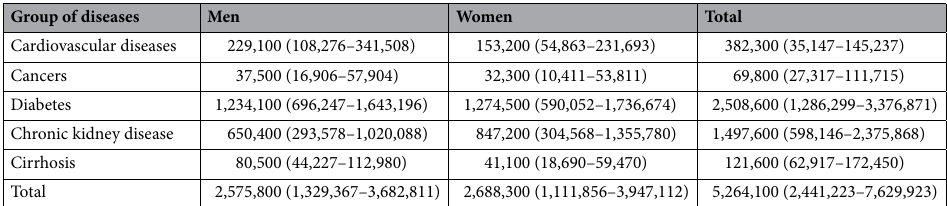
Table 2. Incident cases of non-communicable diseases attributable to overweight over a 10-year simulation period, from 2021 to 2030, in Brazilian adults aged 20–79 years. Brackets contain 95% uncertainty intervals.